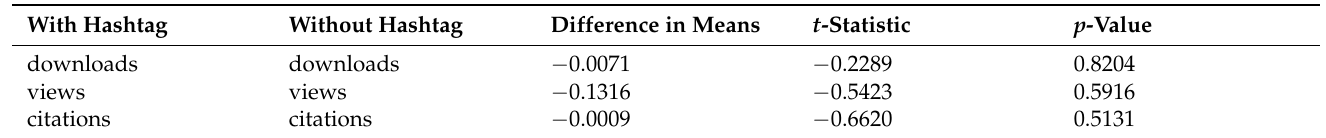
Table 12. Results of the Welch’s test on the metrics associated with papers tweeted as #johdpapers and papers that were not